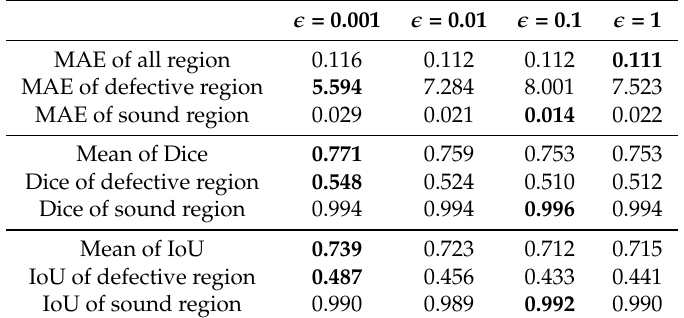
Table 4. Results of the proposed method with different values of (cid:101) .